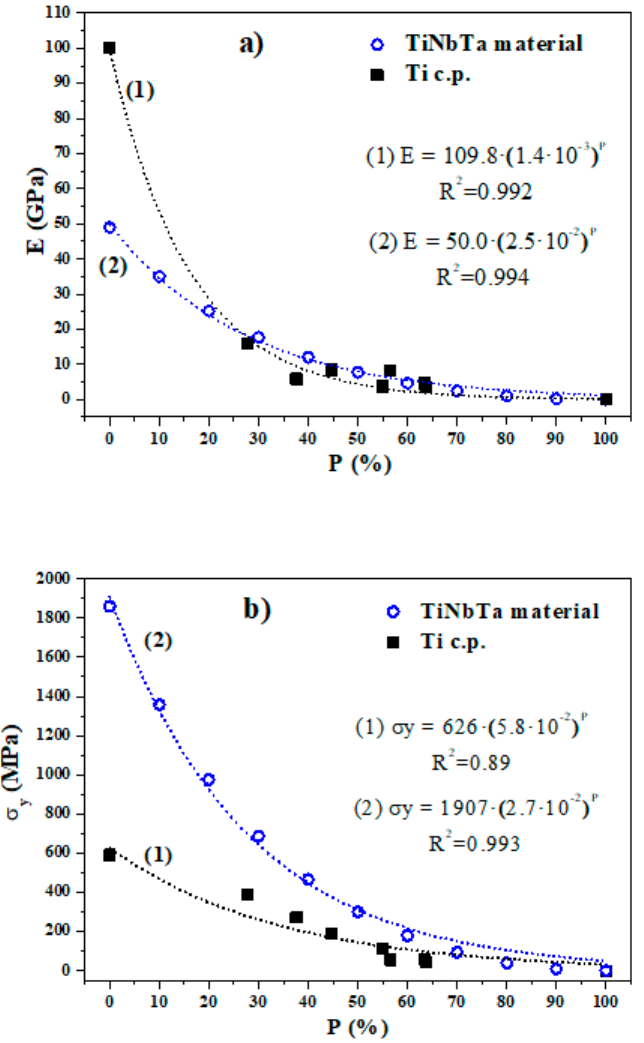
Figure 3. ( a ) Elastic modulus (E) and ( b ) yield strength ( σ y) for both TiNbTa material ( determined by the Mondal equation, except the experimental values obtained from the compres- sion test for fully dense TiNbTa, and that the values for Ti c.p. are experimentally obtained in pre- vious work. The equations displayed correspond to the best fit (exponential curves) to the serial data.